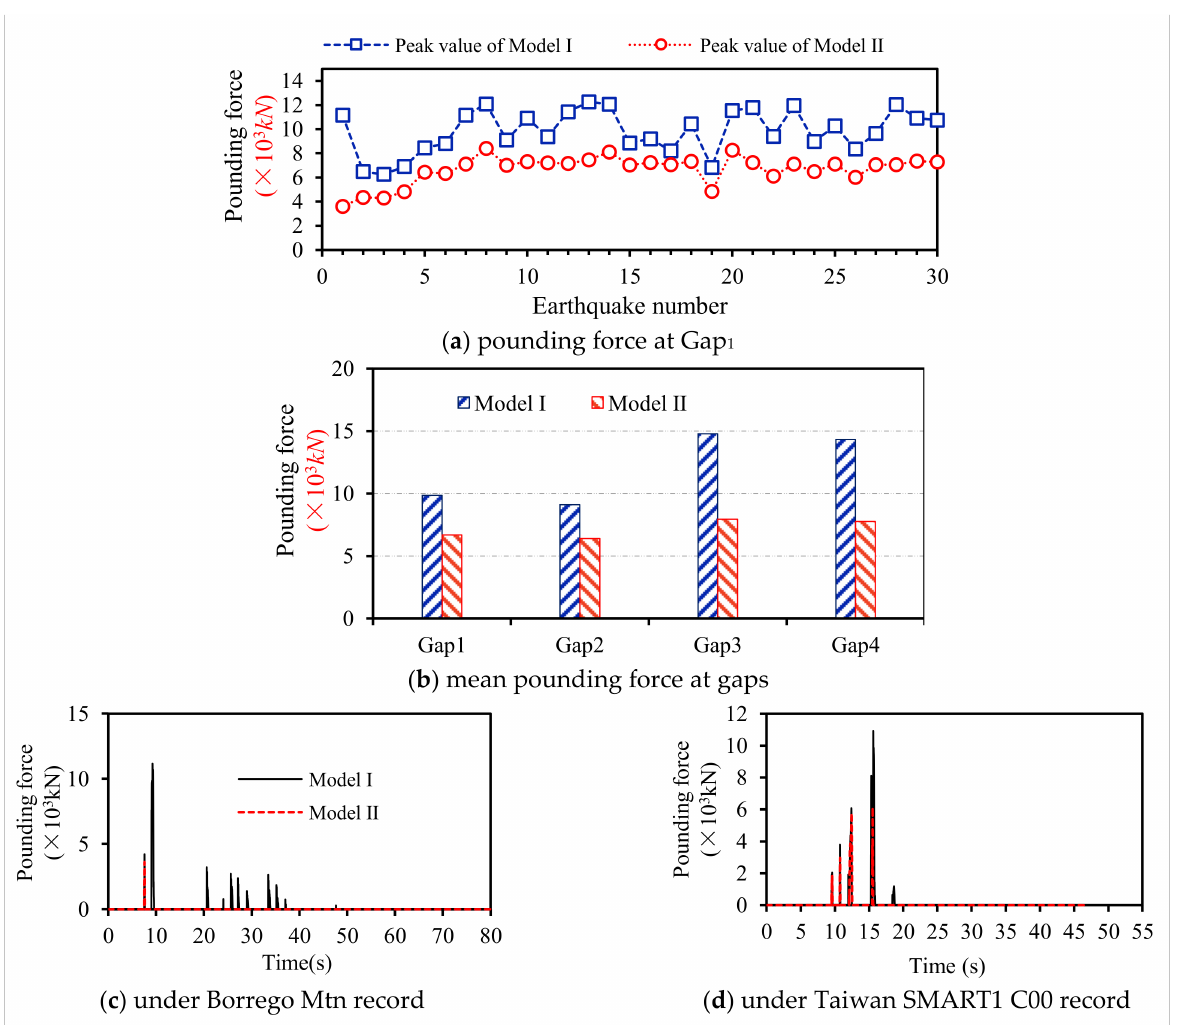
Figure 8. Pounding force